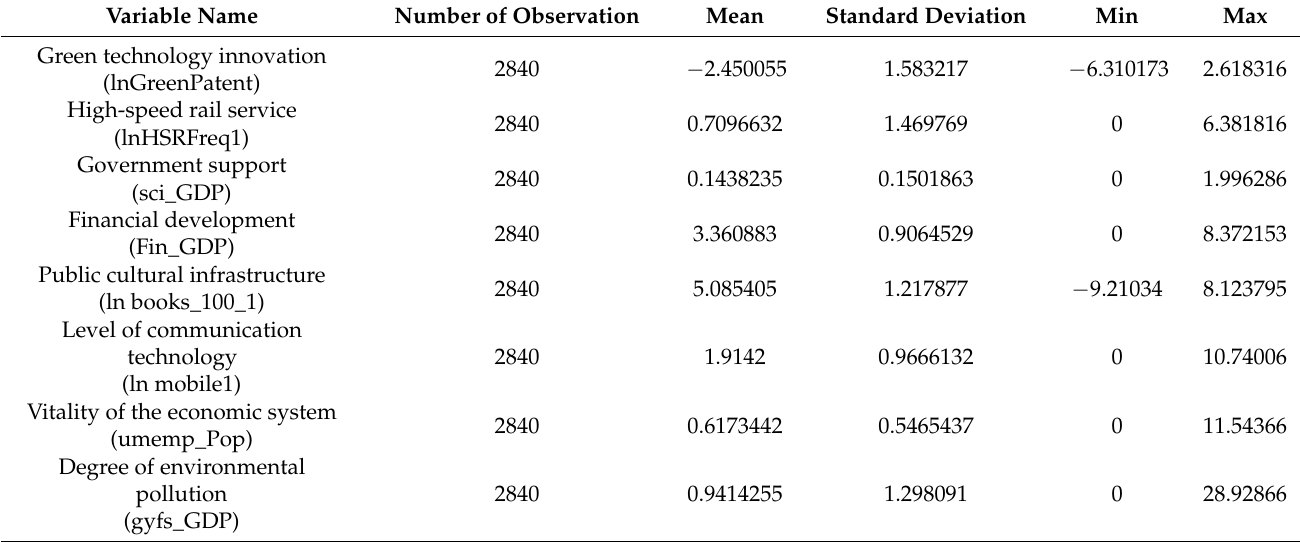
Table 1. Statistical description of